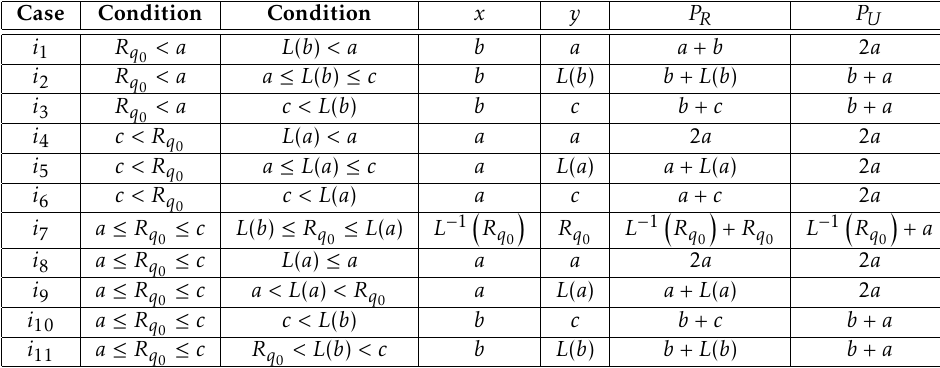
Table 1. The equilibrium strategies ( x, y ) with L − 1 ( R probabilities of the Invader with reward related and un-related to the bandwidth used.